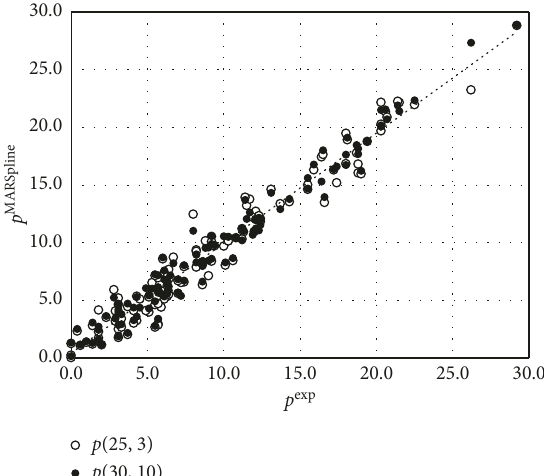
Figure 4: The correlation between experimental and computed values of parameter p prediction is done using Eq. (1). The quality of the chosen optimal p (25, 3) model is characterized by fitting criteria: R 2 � 0.9425, ( R adj ) 2 � 0.9325, LOF � 4.4911, K xx � 0.3758, RMSE tr � 1.4998, MAE tr � 1.1902, F � 94.8671, and N � 130, and fulfils the following internal validation criteria: ( Q loo ) 2 � 0.9100, RMSE cv � 1.8765, and MAE cv � 1.4655 [71, Table 2: MARSplines p (25,3) model regression factors along with their weights.